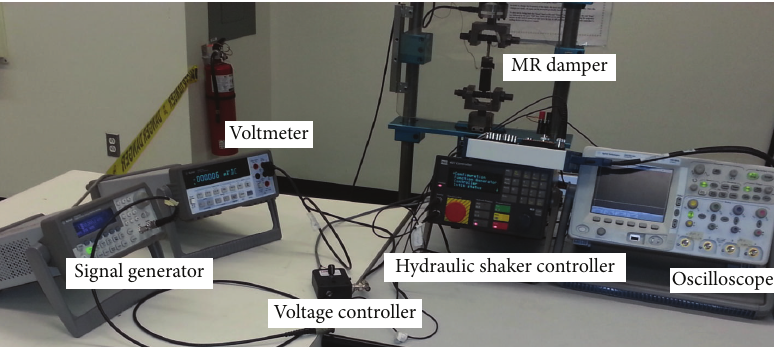
Figure 2: Experimental setup.